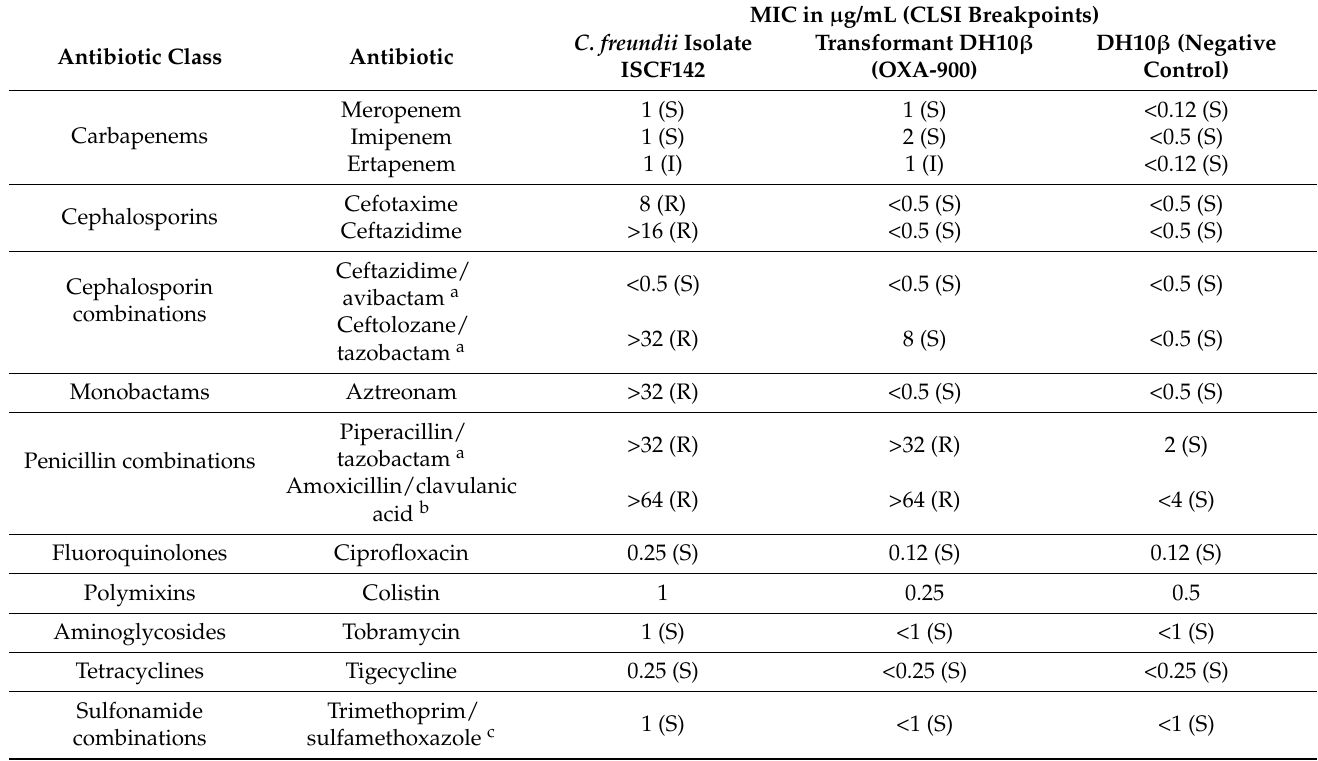
Table 1. Antibiotic susceptibility profile by broth microdilution of C. freundii ISCF142, E. coli DH10 β -harboring recombinant β -lactamase bla β without the β -lactamase gene insert (negative OXA-900 , and E. coli DH10